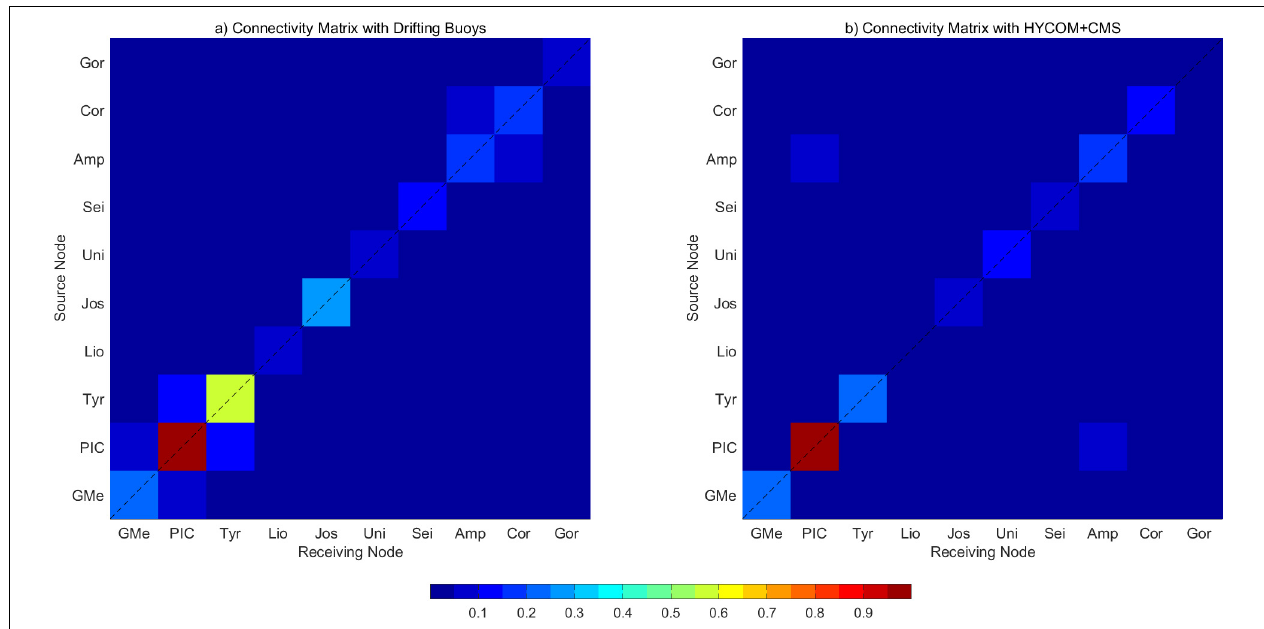
FIGURE 2 | Connectivity matrices computed for the connectivity study area and the time period from 2004 to 2012. (a) Connectivity matrix computed with drifting buoys data from CORIOLIS. (b) Connectivity matrix computed with HYCOM and CMS.